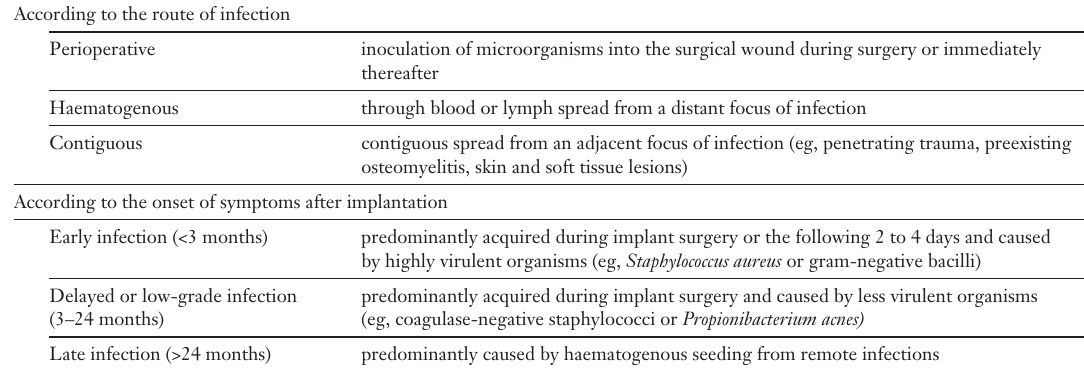
Classification of pros- thetic joint